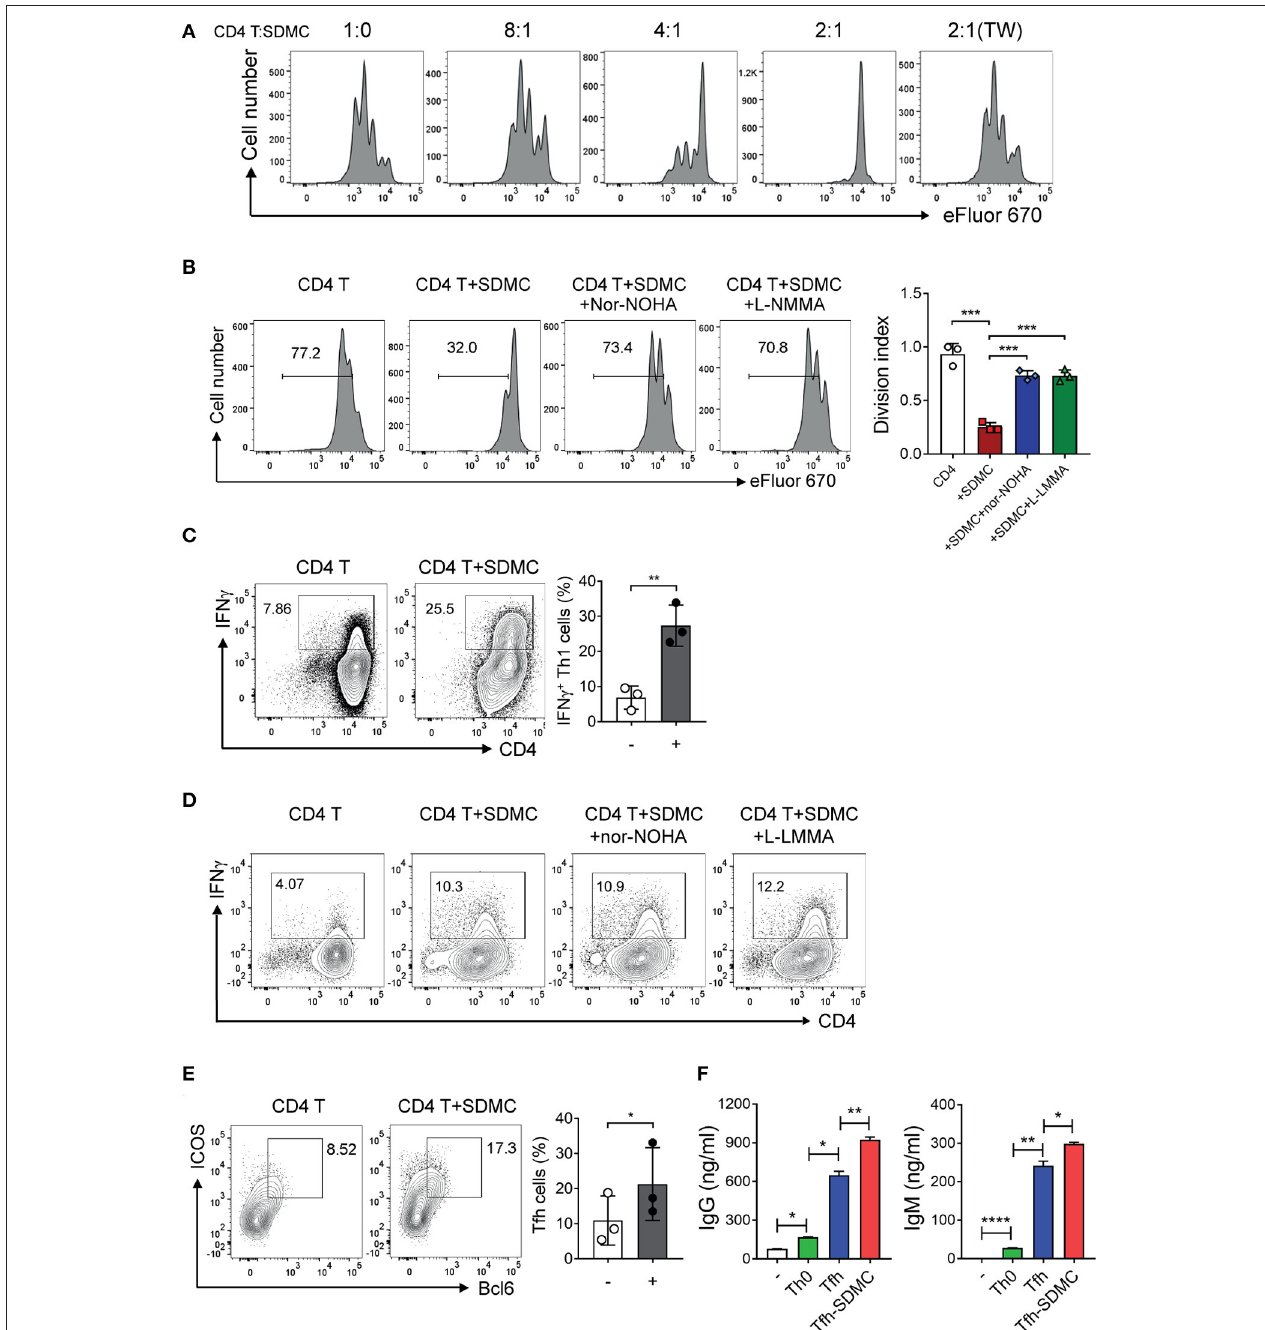
FIGURE 4 | Effects of SDMC on the proliferation and differentiation of CD4 + T cells. (A,B) CD4 + T cells stained with eFluor 670 were stimulated with anti-CD3 and anti-CD28 mAbs in the presence or absence of SDMCs from sanroque mice at the indicated ratios (A) and a 2:1 ratio of CD4 + T cells: SDMCs (B) . In some wells, transwells (TW) were used to separate SDMCs and CD4 + T cells (A) and inhibitors were added as indicated (B) . (C–E) CD4 + T cells were cultured under Th1- (C,D) or Tfh-polarizing conditions (E) in the presence or absence of SDMCs and inhibitors, and assayed by intracellular FACS. (F) CD4 + T cells treated as in E were co-cultured with syngeneic B cells in the presence of anti-IgM and IL-4 and culture supernatants were assayed by ELISA. Data are displayed as the means ± SDs with symbols representing the values of individual mice and are representative of 2 independent experiments. * p < 0.05, ** p < 0.01, *** p < 0.001, and **** p < 0.0001 by Student’s t